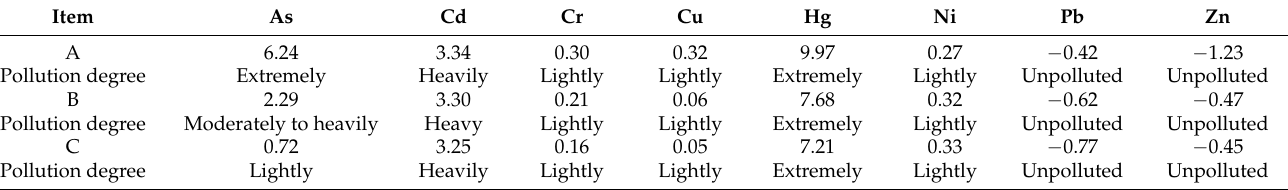
Table 8. Calculation results of I geo .